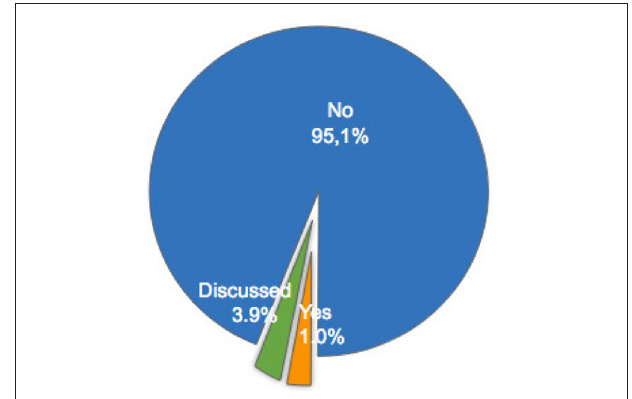
FIGURE 12 | Distribution of the application of the diagnosticity criteria.